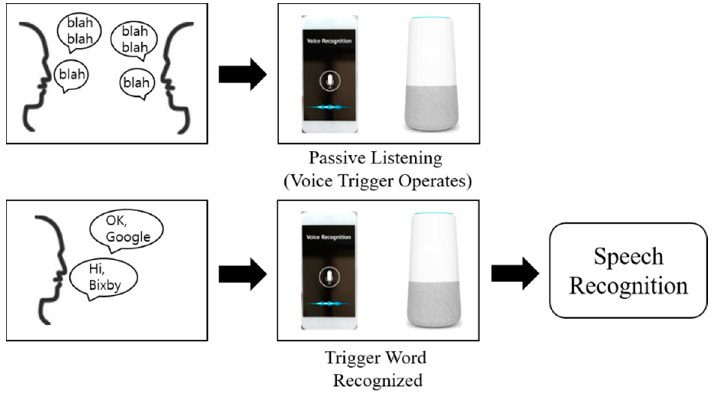
Figure A3. Standard voice interface operation in smart devices [30].